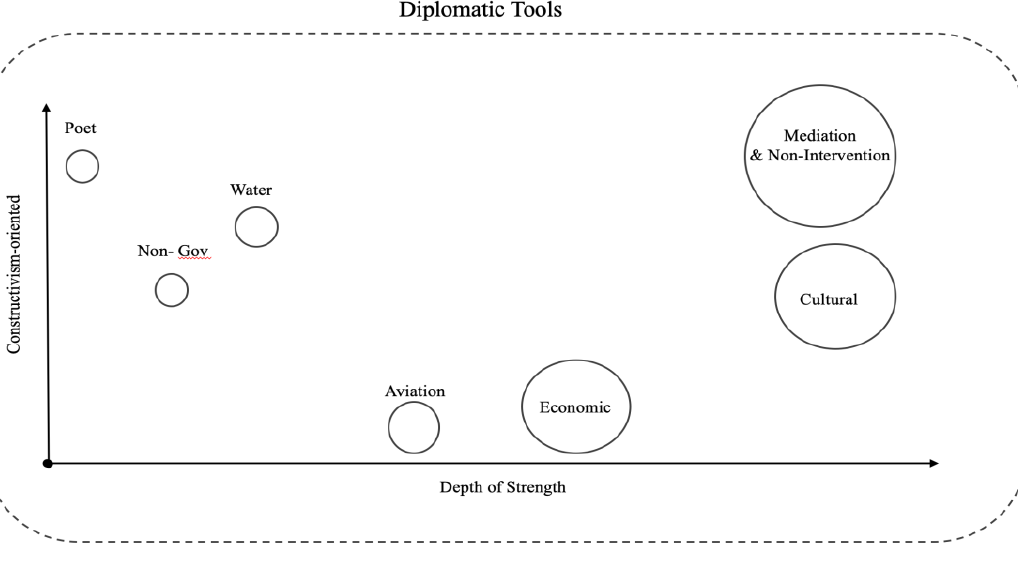
Fig. 1: Diplomatic